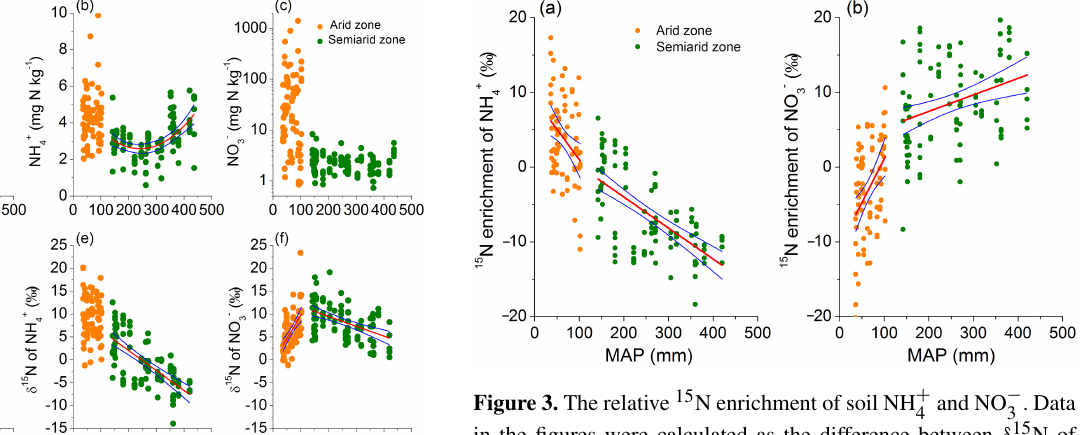
and NO − . Data 4 3 and NO − , 4 3